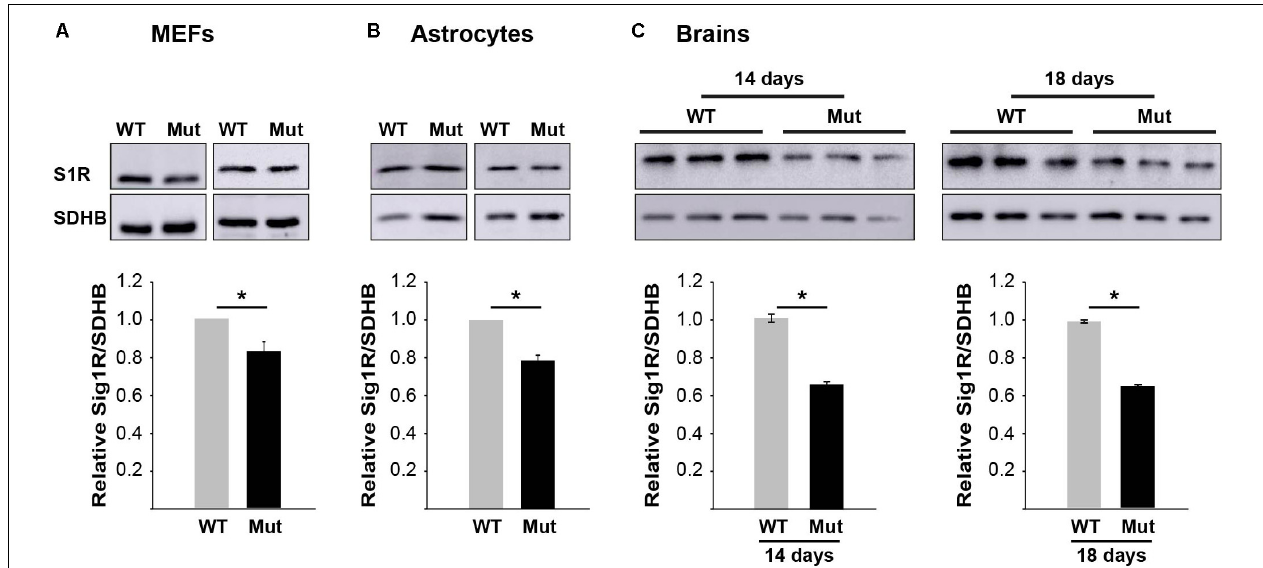
FIGURE 4 | S1R protein level is lower in mutants. Equal amounts of total protein of primary MEFs (A) , primary astrocytes (B) , or brains at postnatal age of P14 and P18 (C) isolated from WT and mutant mice were subjected to immunoblot analysis using antibodies specific for S1R and SDHB as a marker for mitochondria content. Shown are representative blots (top) and calculated S1R/SDHB ratio ± SEM of three to six independent experiments (bottom). ∗ p = 0.02 (MEFs), ∗ p = 0.01 (astrocytes), ∗ p = 0.048 (p14 brains), and ∗ p = 0.003 (p18 brains).